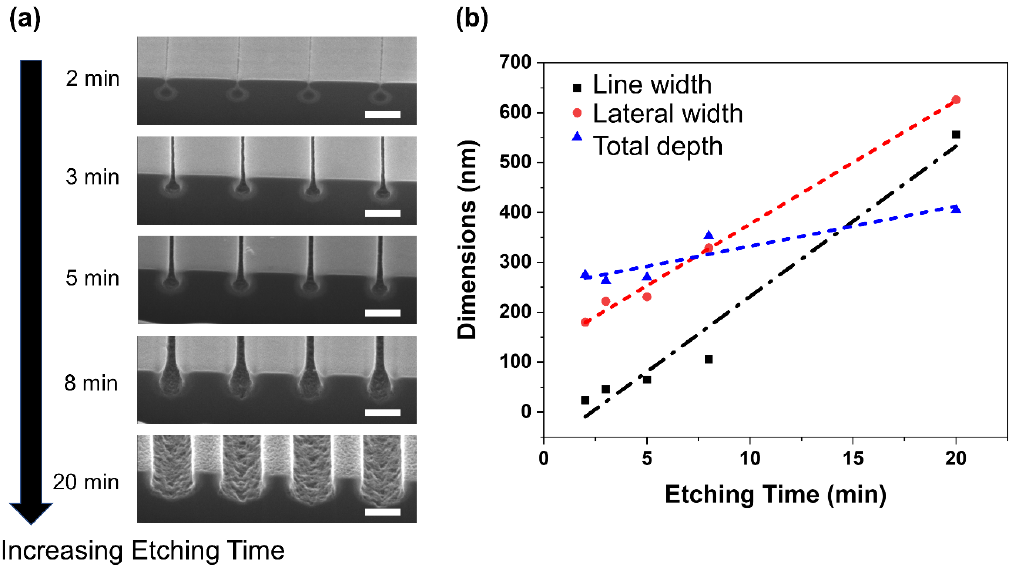
Figure 4. Si nanostructures produced by HIBEE using 2, 3, 5, 8, and 20 min of wet etching time. ( a ) SEM images. ( b ) Plots of line width, lateral width, and total depth of the nanostructures. The scale bar is 500 nm.